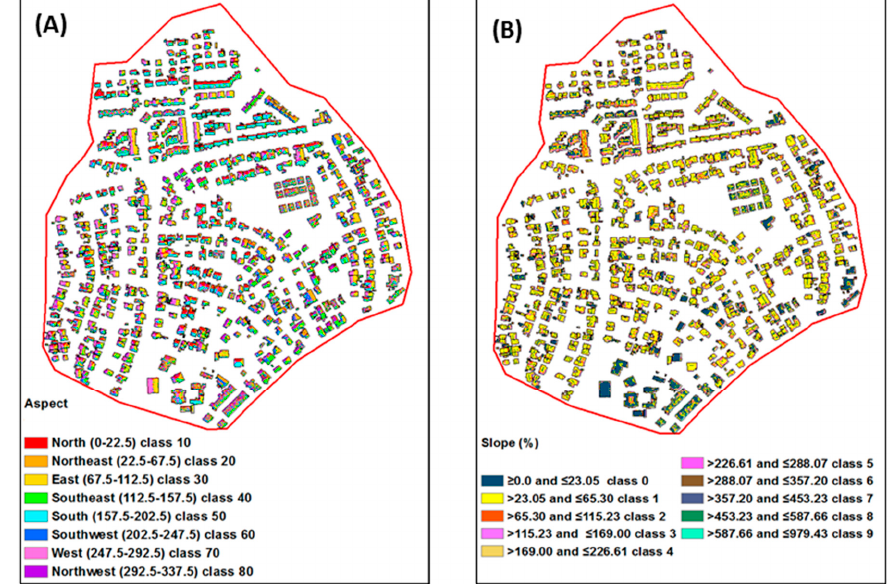
Figure 6. ( A ) Aspect reclassification, ( B ) slope reclassification.